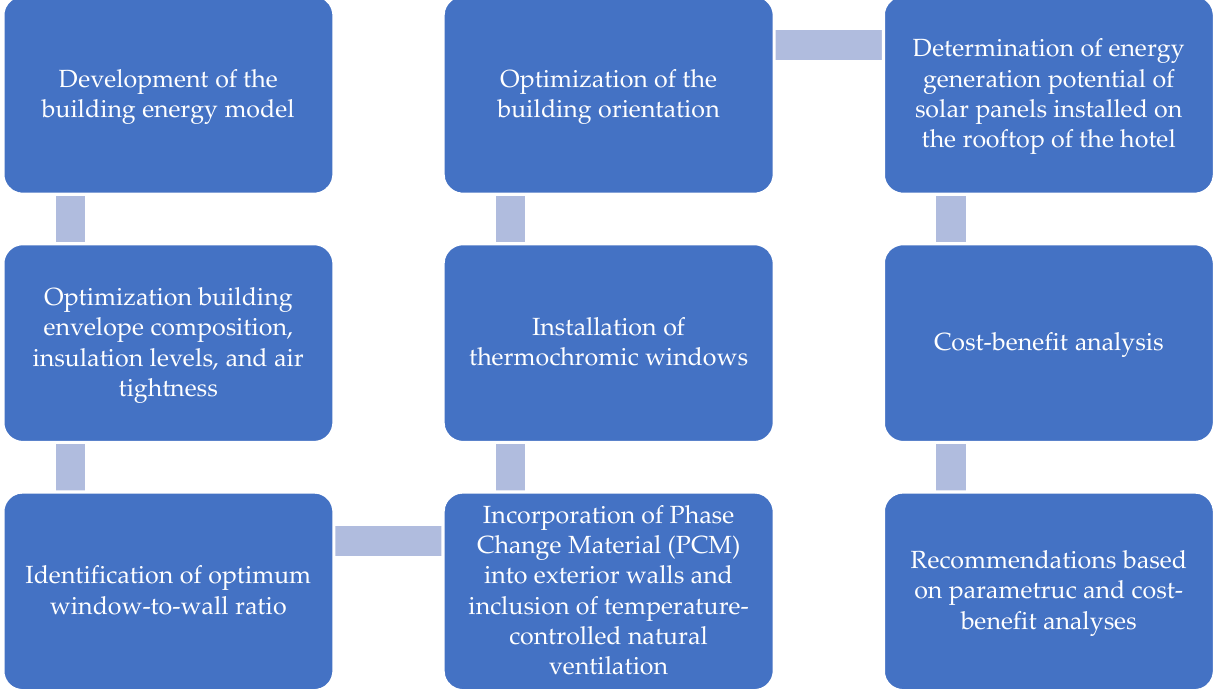
Figure 1. The flow of the research work.